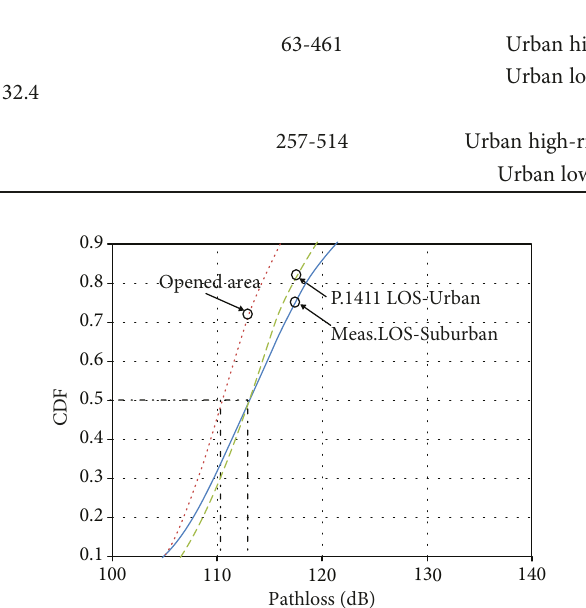
Figure 15: CDF in LoS environment (at site-general).